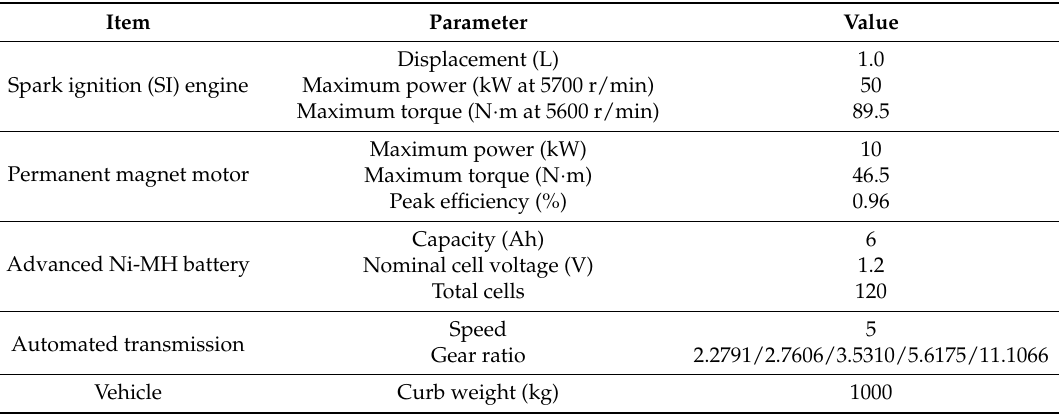
Figure 1. Configuration of the parallel HEV drive train. Table 1. Important parameters of the parallel HEV.